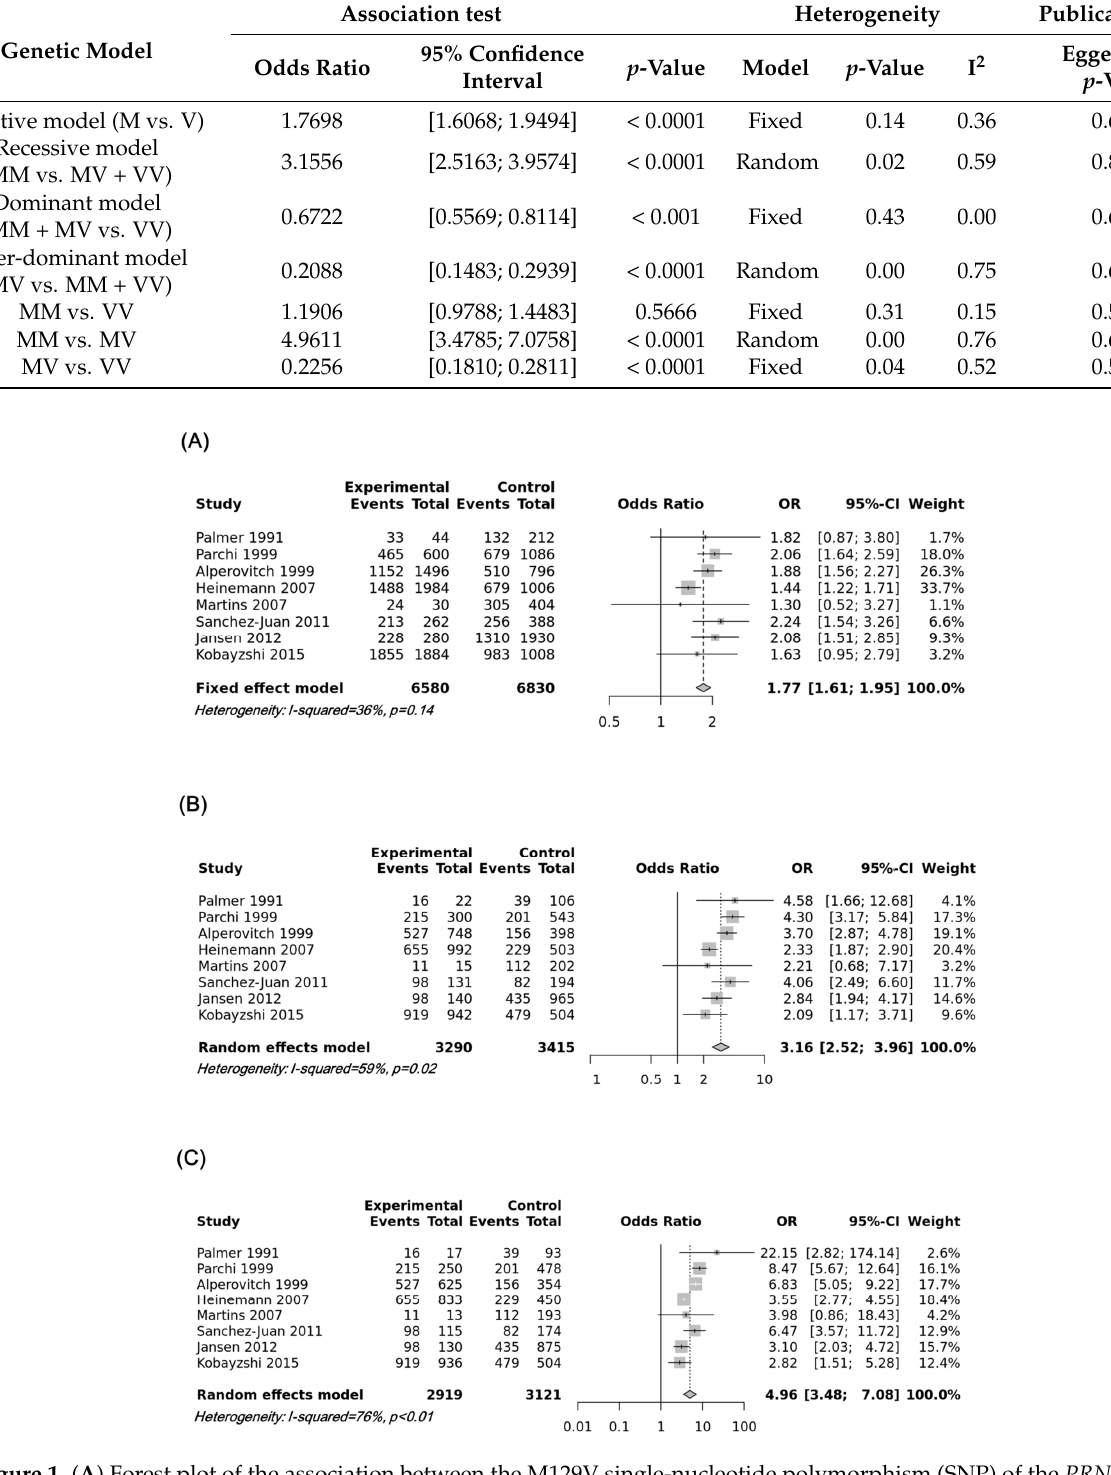
Figure 1. ( A ) Forest plot of the association between the M129V single-nucleotide polymorphism (SNP) of the PRNP gene and susceptibility to sporadic Creutzfeldt–Jakob disease (CJD) in the additive model (M vs. V). ( B ) The forest plot for the association between the M129V SNP of the PRNP gene and susceptibility to sporadic CJD in the recessive model (MM vs. MV + VV). ( C ) The forest plot for the association between the M129V SNP of the PRNP gene and susceptibility to sporadic CJD in the heterozygote comparison (MM vs.